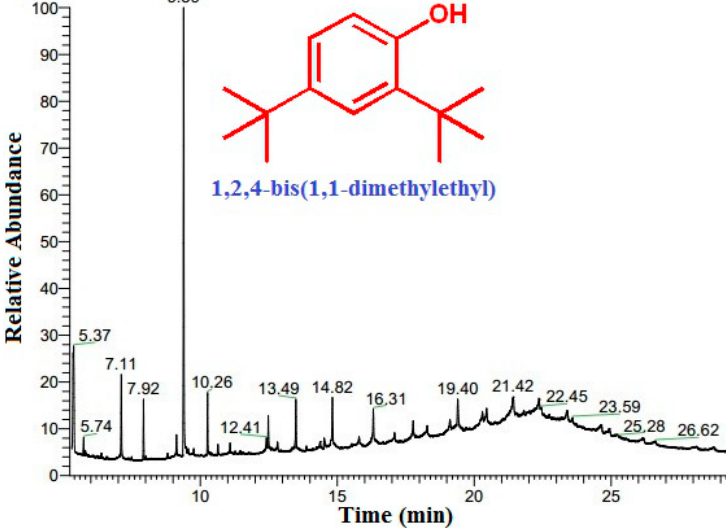
Figure 3. GC-MS chromatogram of A. plumula extract.